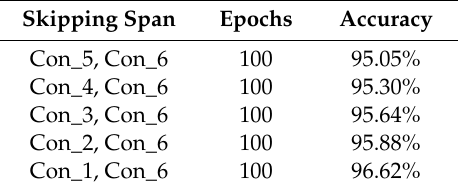
Table 5. Comparison between SSE Module at di ff erent skipping span.